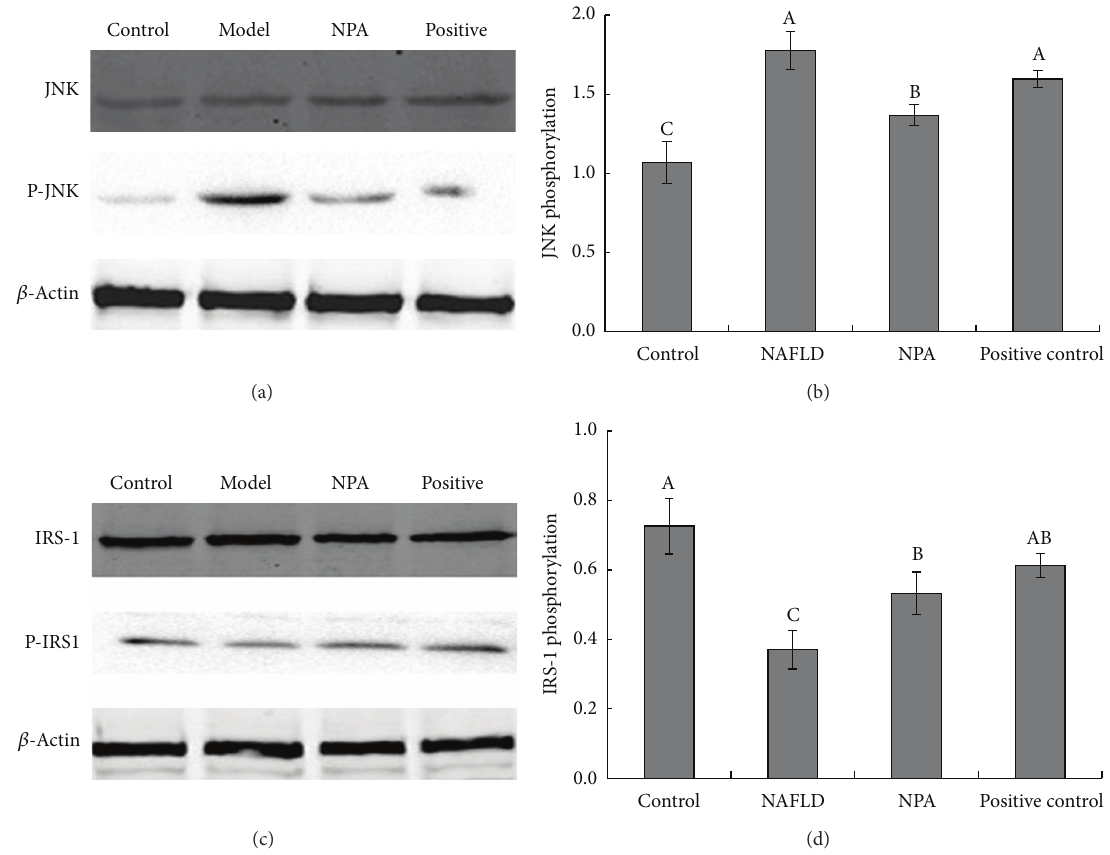
Figure 4: Effect of NPA on phosphorylation of JNK (a) and IRS-1 (c) in the hepatic tissue of NAPLD rats analyzed by western blot. Phosphorylation levels were evaluated by the band strength of P-JNK/JNK or P-IRS1/IRS (b and d). Liver and adipose tissue protein blots were normalized to endogenous 𝛽 -actin. Different letters (A, B, or C) upon each column represent significant differences between the treated groups ( 𝑃 < 0.05